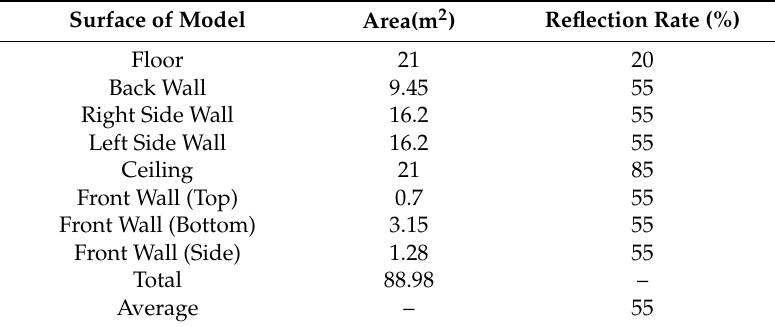
Table 3. Properties of simulation model.